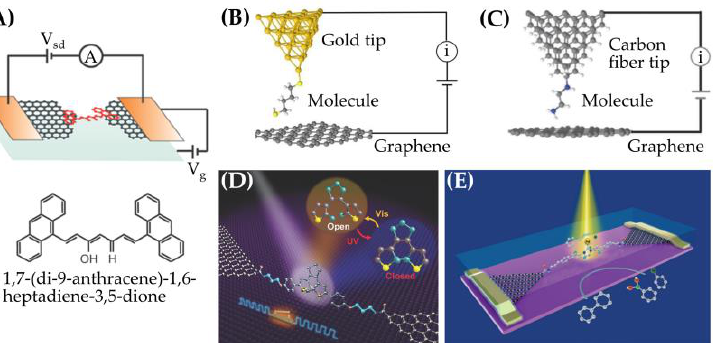
Figure 7. Recent advances in carbon-based electrodes for single-molecule junctions. ( A ) A single- molecule transistor in which the source and drain are a pair of graphene electrodes prepared via feedback-controlled electroburning. The model molecule was (1,7-(di-9-anthracene)-1,6-heptadiene- 3,5-dione, and the molecule–electrode contact was made by π - π stacking through the anthracene moiety. ( B , C ) Single-molecule junctions of α , ω -alkanes on graphene electrodes. The junctions are formed with the STM i(s) mode. The tips in panels B and C are gold and carbon fiber, respectively. ( D ) A diarylethene molecule covalently bonded to graphene electrodes. The molecule transformed between the open and closed forms under visible and ultraviolet irradiation, respectively, exhibiting the electric behavior of photoswitching. ( E ) A single-molecule catalyst containing a Pd center is covalently bridged in a pair of graphene electrodes. The Pd complex activates the Suzuki–Miyaura cross-coupling reaction. By monitoring the current across the junction, the reaction mechanism and the associated kinetic and thermodynamic information are derived. The figures are adopted from